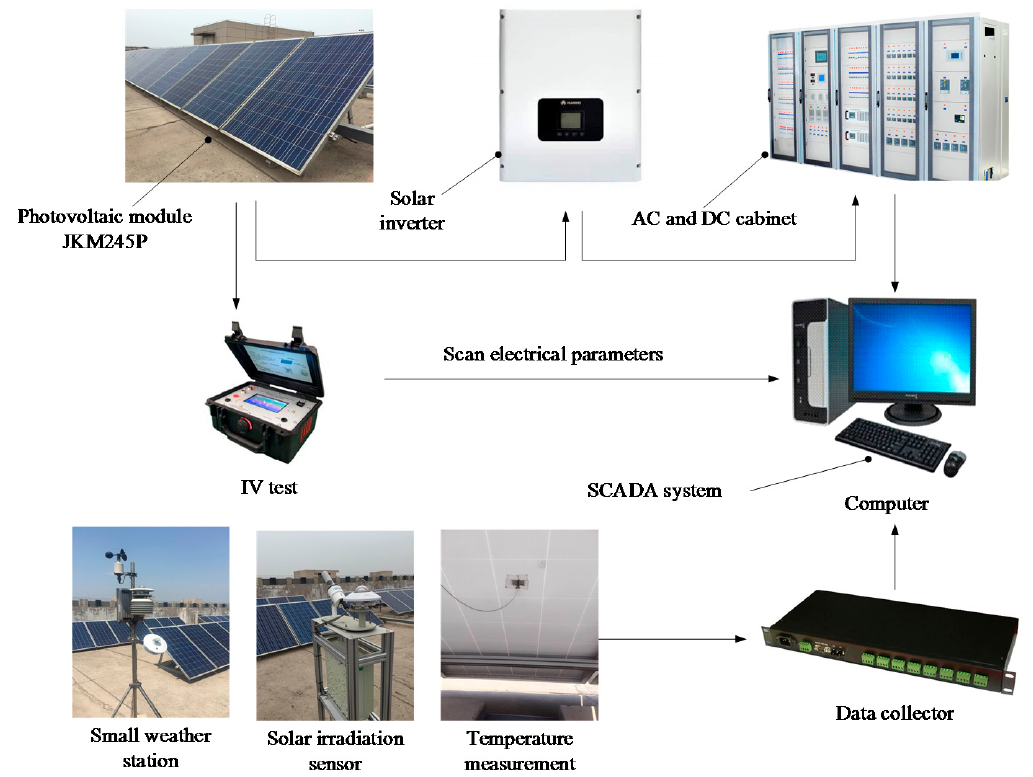
Figure 10. Outdoor experimental PV module platform. Table 10. The description of the experimental equipment.